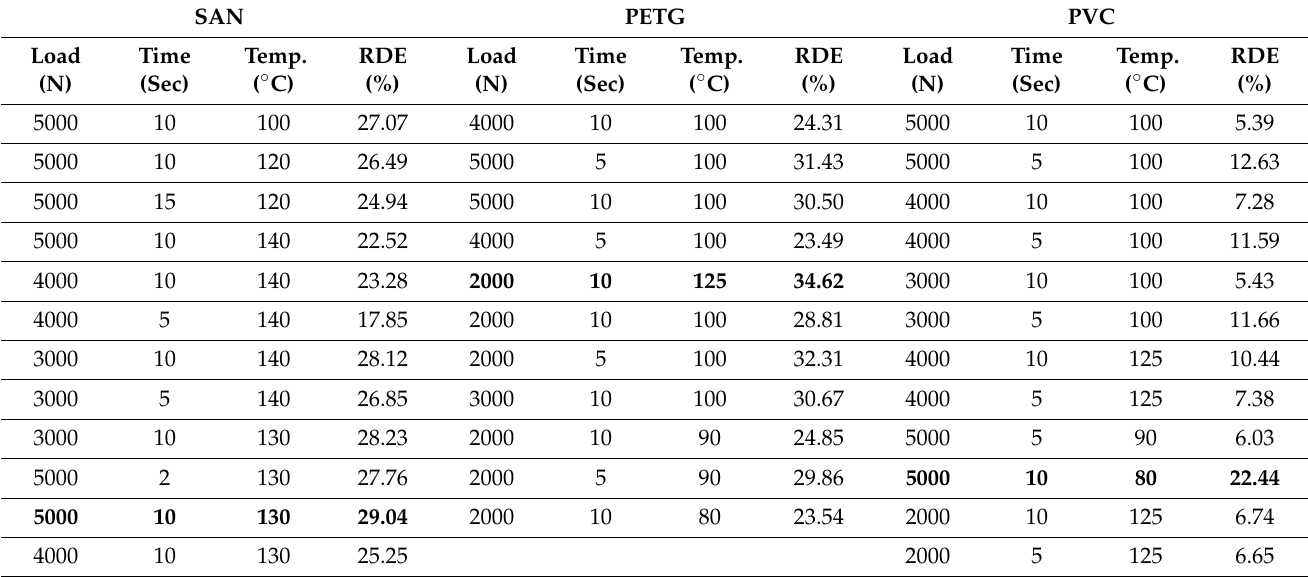
Table 5. Diffraction efficiency measurement results.